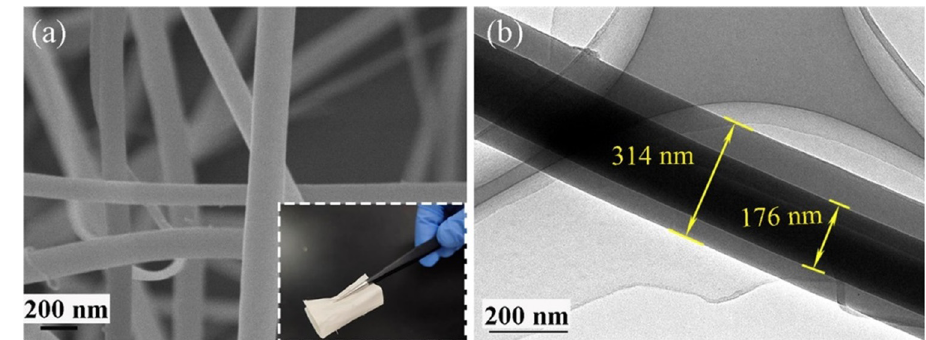
Figure 9: ( a ) SEM and ( b ) TEM images of CNFs. Copied with permission from ref. [ 58 ] ; Elsevier,